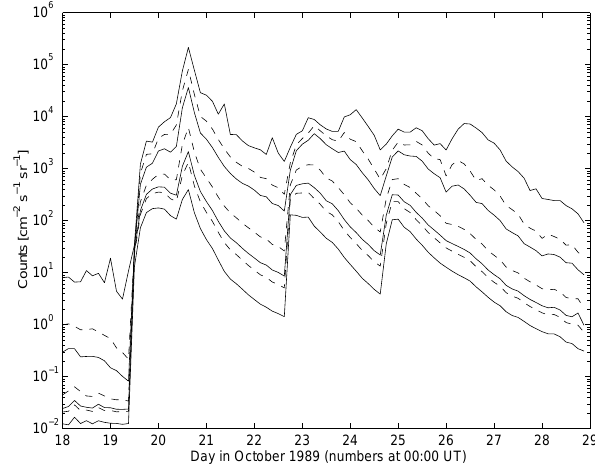
Fig. 1. Integrated proton fluxes for late October 1989 (obtained from the World Wide Web server for the NOAA National Geo- physical Data Center), showing three-hour averages of the seven energy channels of the GOES satellite proton measurements. From top curve down the channels are: > 1, > 5, > 10, > 30, > 50, > 60, and >